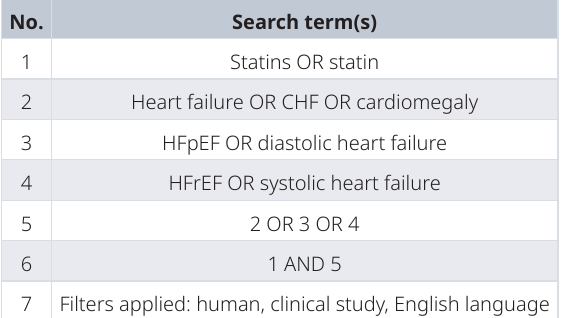
Table 1. Search strategies on OVID Medline.